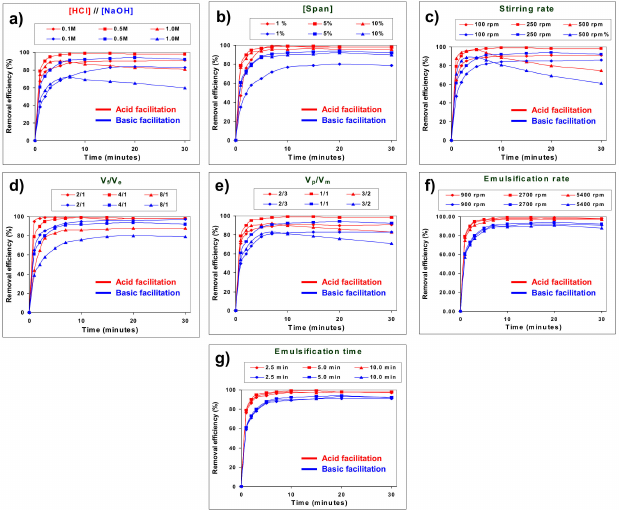
Figure 2. Effect of different experimental conditions on the removal efficiency of 4-aminophenol from the feed phase by acid and basic type 1